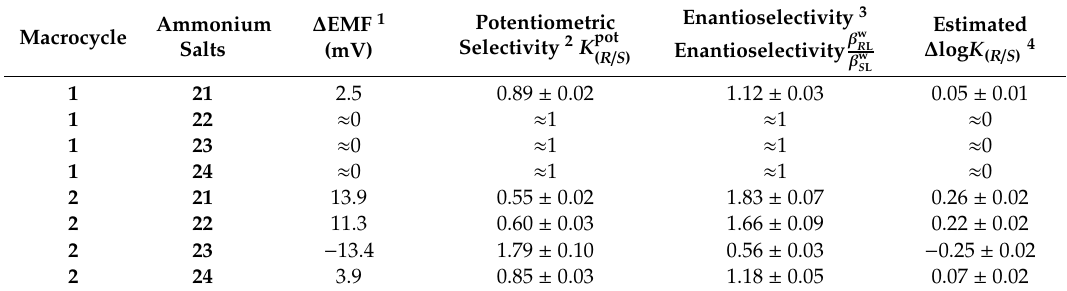
Table3. Selectivityofligands( R , R )- 1 and( R , R )- 2 fortheenantiomersofaralkylaminehydrochloridesalts 21 – 24 expressed as the di ff erence in EMF values in 10 − 3 M aralkylammonium chloride solutions and the corresponding potentiometric and enantioselectivity factors obtained by carrying out 12 measurements.